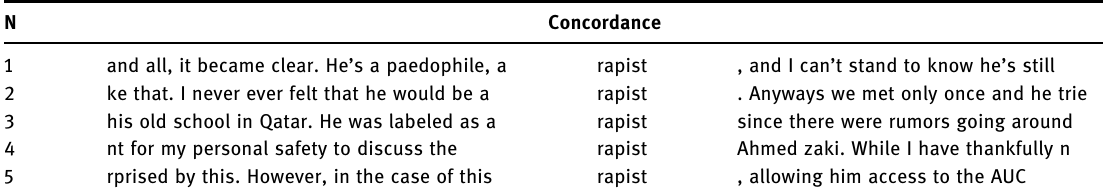
Table 12: Concordance lines for rapist